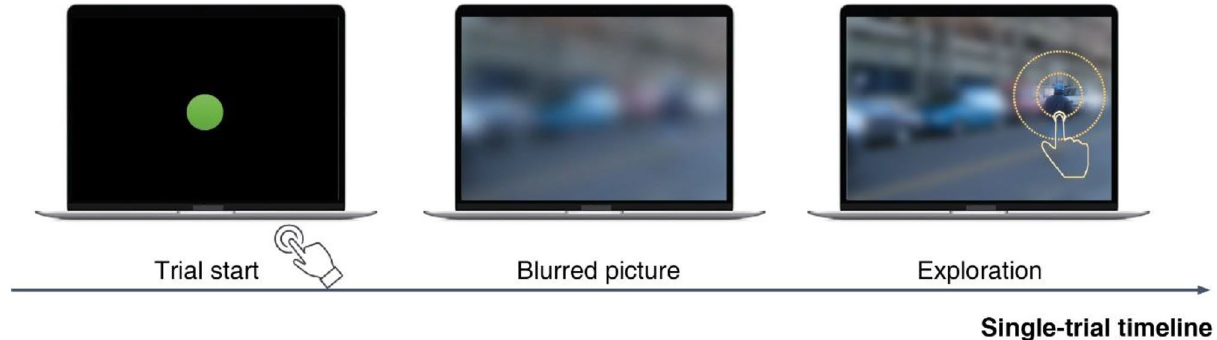
Figure 1. An illustration of the task. Participants saw a green button on the screen center. After touching the button, they could see the image superimposed by the gaussian blur. Touching the screen can sharpen an area around the finger, simulating the central vision. To clearly illustrate the Gaussian blur, the size of clear area here was larger than the size participants observed during the